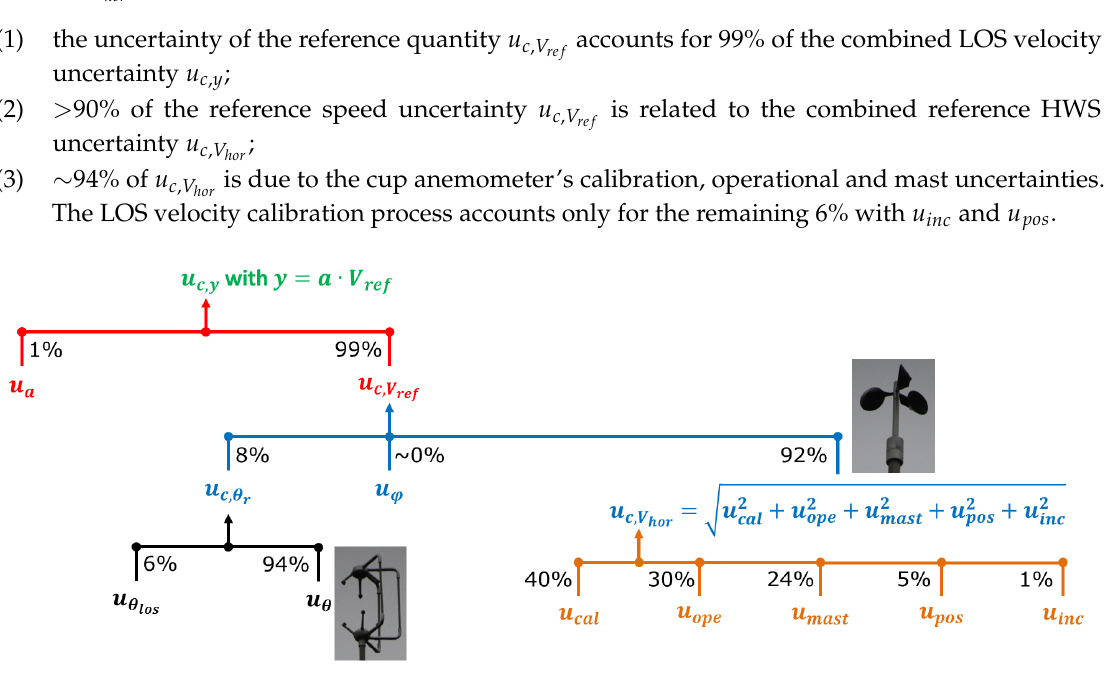
Figure 14. The ‘tree’ structure of the uncertainty assessment methodology including relative contributions of individual uncertainty